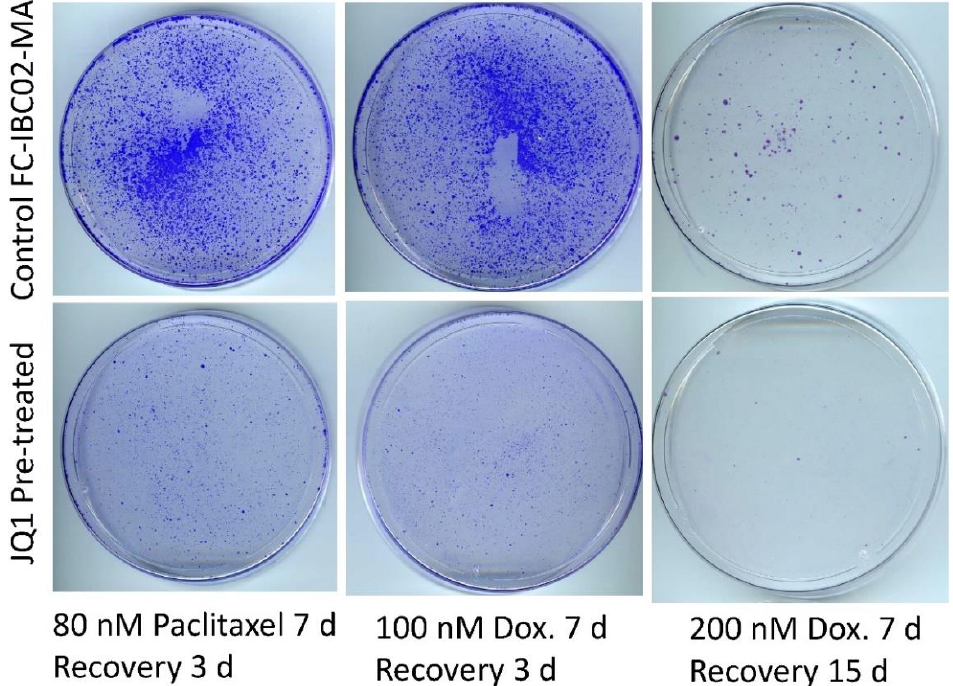
Figure 6. Pretreatment with JQ1 sensitizes FC-IBC02-MA cells to chemotherapeutic drugs. After 6 days of treatment with 62.5 nM of JQ1, we allowed the surviving cells to recover in a drug-free medium for 6 days. We plated the cells into fresh culture dishes and treated with 80 nM of paclitaxel (left panel) or 100 nM of doxorubicin (Dox, middle panel) for 7 days and then let them recover and grow into colonies for 3 days before staining them with crystal violet. We also treated cells with a high dose (200 nM) of doxorubicin for 7 days and allowed the surviving cells to recover for 15 days before staining the colonies (right panel). These images show that pretreatment with JQ1 markedly decreased the number of colonies. Passage numbers in cell culture: FC-IBC02-MA, passage 27; FC-IBC02, parental cell line at passage 21 shifted to glutamine-free medium for 6 passages.